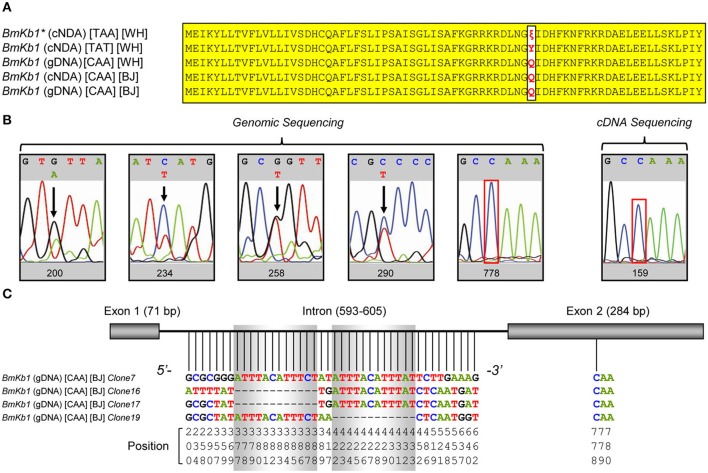
Polymorphism of BmKb1. (A) Precursor proteins encoded by BmKb1 and its mutants. Variations at site 50 are shown in red and identical sites are shadowed in yellow. (B) Sequencing PCR products amplified from genomic DNA and cDNA for identifying polymorphic sites. (C) Sequencing different genomic clones identifying polymorphism in the intron region of BmKb1.